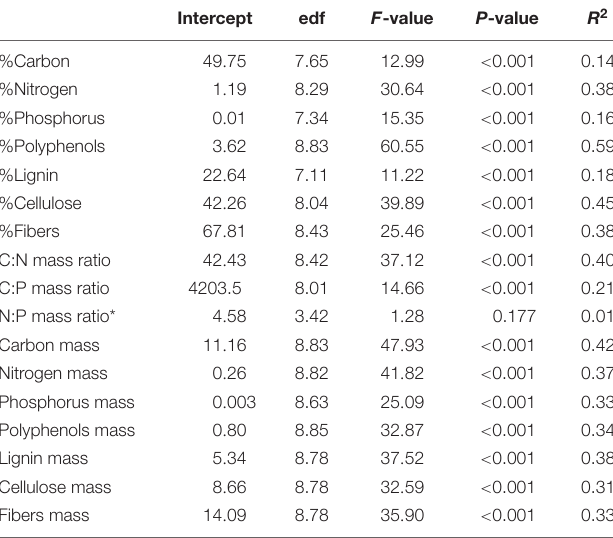
TABLE 1 | Results of generalized additive mixed models (GAMMs) exploring non-linear temporal patterns of litter traits in terms of concentrations (%) or mass (g m − 2 month − 1 ) of each compound or C:N, C:P, and N:P ratios over 2